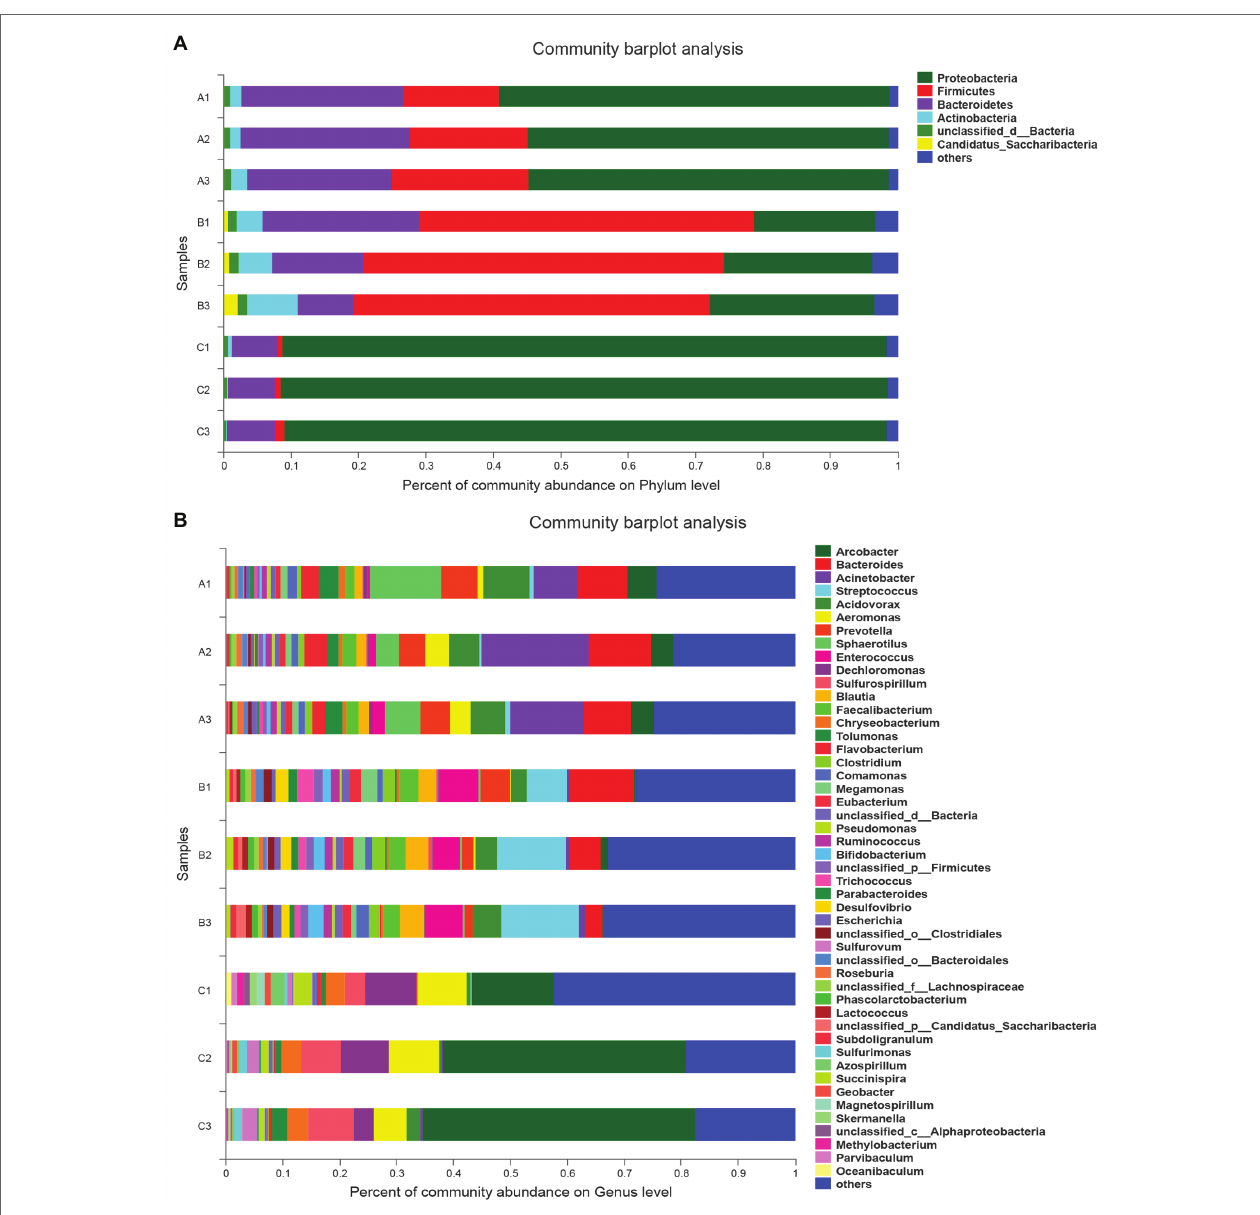
FIGURE 1 | Percent of community abundance of microbiota on Phylum and Genus level in wastewater from hospitals. (A) Percent of community abundance on Phylum level; (B) Percent of community abundance on Genus level. A group (A1, A2, and A3): wastewater from Affiliated Hospital of Southwest Medical University, B group (B1, B2, and B3): wastewater from Affiliated Traditional Chinese Medicine (TCM) Hospital of Southwest Medical University, C group (C1, C2, and C3): wastewater from Hospital of Stomatology Southwest Medical